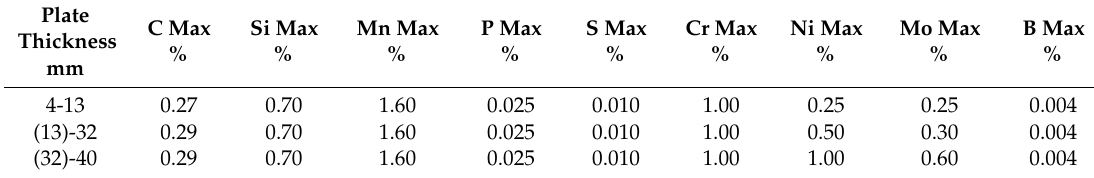
Table 1. Chemical composition of the Hardox TM 500 plate samples